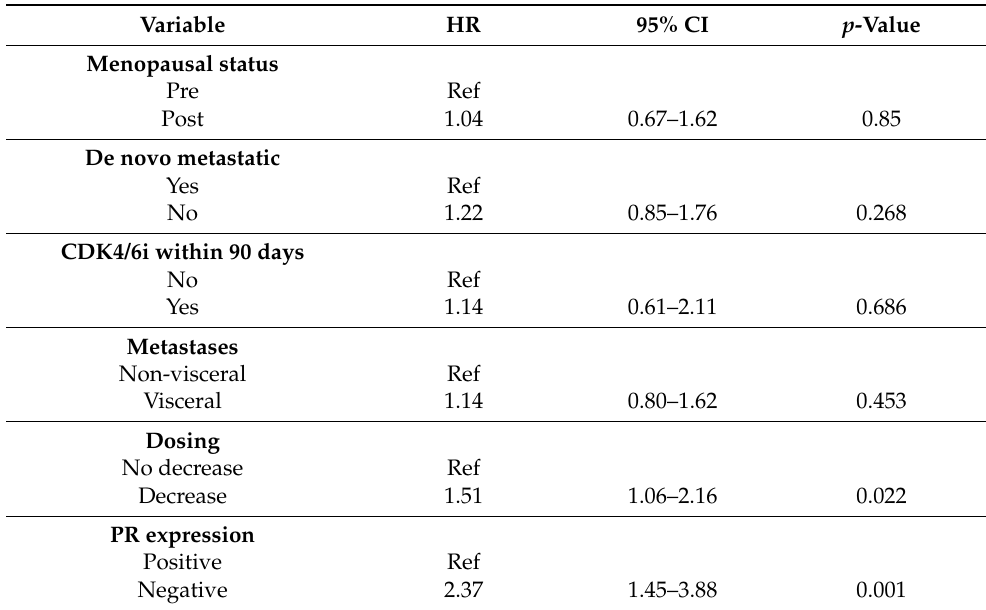
(Table 2). Menopausal status, relapsed disease, visceral metastases, and a gap between the start of CDK4/6i and AI were not significantly associated with PFS. Table 2. Multivariable Cox model for